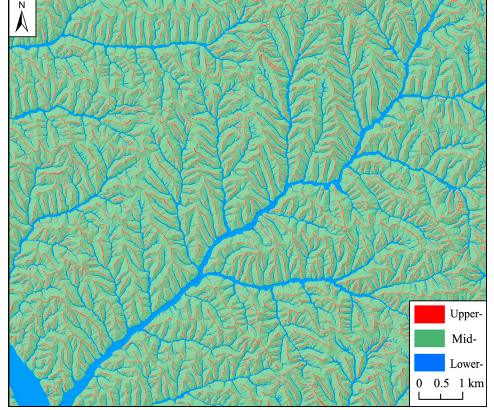
Figure 6. Terrain positions at the first level.